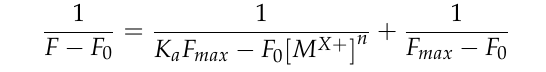
Figure 7. ( a ) The binding ratio of F6 to Al 3+ ; ( b ) Benesi–Hildebrand plot of probe F6 with Al 3+ ; ( c ) The possible binding mechanism of probe F6 to Al 3+ .